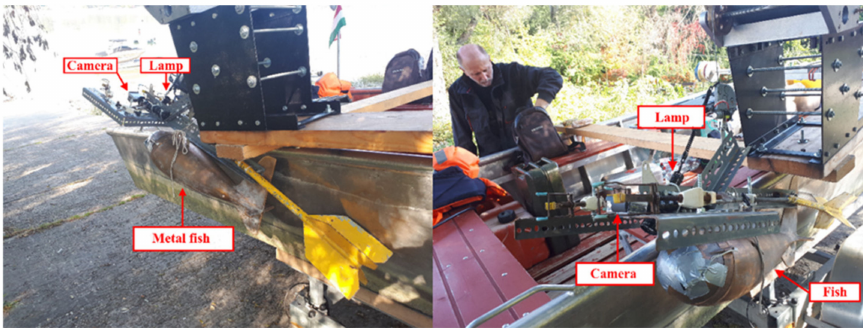
Figure 5. Equipment setup for riverbed imaging: an aluminum frame with an action camera, diving lamp, isokinetic